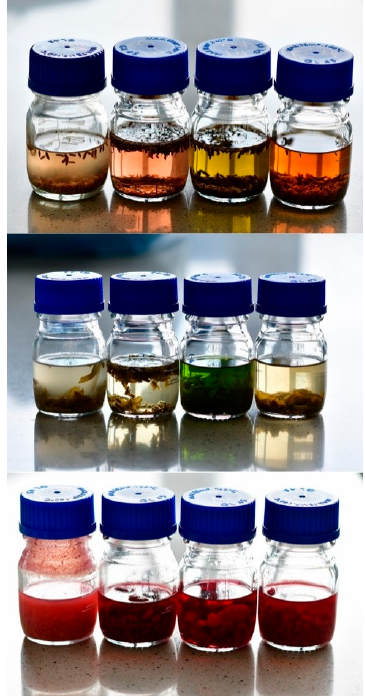
Figure 1. The plant extracts from lavender (top), mint (middle), and raspberry (bottom); from left: fermented vinegars, acetic macerates, tinctures, and decoctions. The types of extract differed in composition (Table 1). Relatively high amounts of vitamin C was found in all rosehip extracts. In the raspberry extracts, ascorbic acid was detected in very small amounts except in the decoction, where ascorbic acid was not found. None of the extracts from apple peels, mint leaves, lavender flowers, and rose petals contained detectable amounts of vitamin C. Table 1. The polyphenols, vitamin C, and carotenoid content in fruit and herbal extracts. Plant